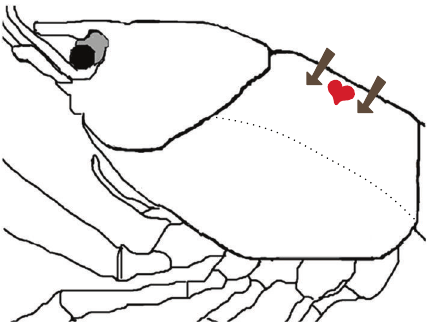
Figure 2: Schematic representation for the placement of the record- ing wires for monitoring the heart from a crayfish (Procambarus clarkii .).Onthedorsalcarapace,largearrowsrepresentthetwowires which spanned the rostral-caudal axis of the heart to monitor any changeinthedynamicresistance,whichisusedasameasureofheart